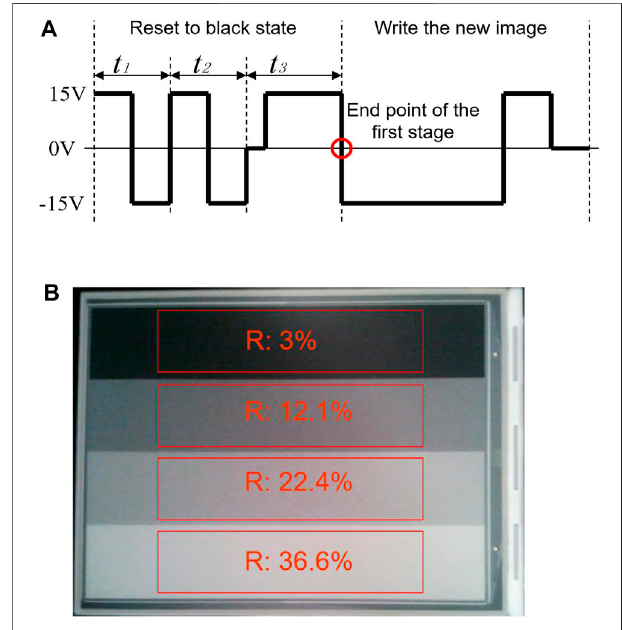
FIGURE 4 | (A) Design details of the new driving waveform, at the end point of the fi rst stage, a black state which has a stable re fl ectance value can be obtained. (B) The real EPD has four-level gray scales which are driven by the proposed driving